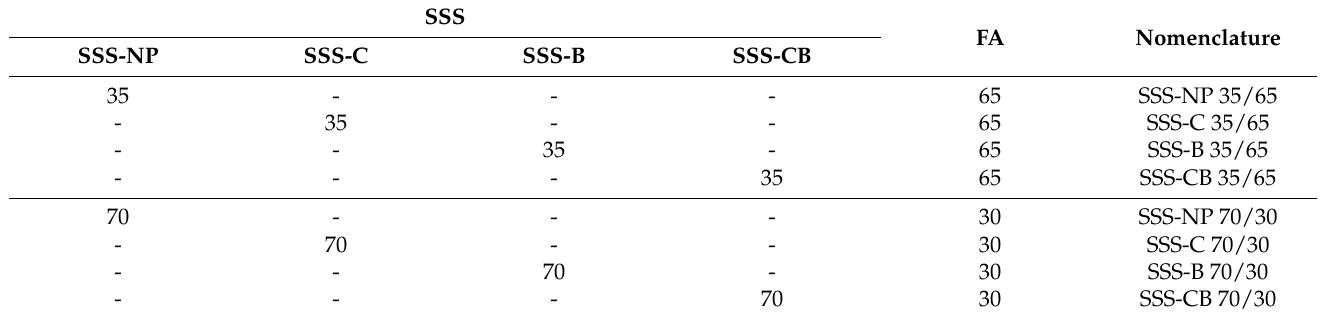
Table 2. Dosage of SSS-FA